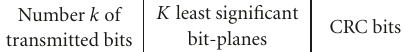
Figure 2: Content of a compressed block for the adaptive DSC